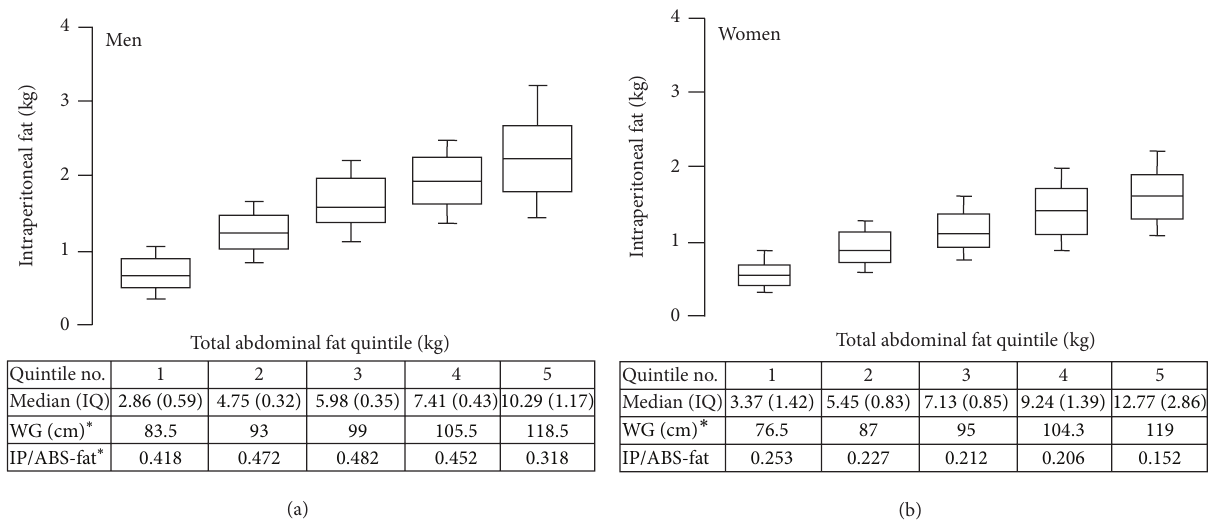
Figure4:(a)Masses(kg)ofintraperitonealfat(IPF)plottedagainstmassesofquintilesoftotalabdominalfatforallmen.IPFmassesincreased progressively with TAF, and the distribution of IPF for each category widened. Boxes show mean and one standard deviation; whiskers show 2 standard deviations. The chart gives median values for each quintile, the mean waist girth, and ratio of IPF to abdominal subcutaneous fat. The latter ratio changed a little across ratios except in the highest quintile. (b) Masses (kg) of intraperitoneal fat (IPF) plotted against masses of quintiles of total abdominal fat for all women. IPF masses increased progressively with TAF, and the distribution of IPF for each category widened. Boxes show mean and one standard deviation; whiskers show 2 standard deviations. The chart gives median values for each quintile, the mean waist girth, and ratio of IPF to abdominal subcutaneous fat. The latter ratio changed a little across ratios except in the highest